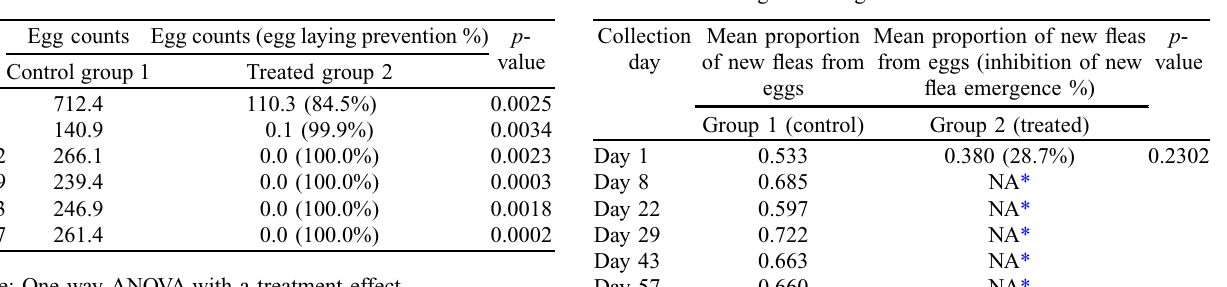
Table 1. Flea egg counts and prevention of flea egg laying (%) using arithmetic